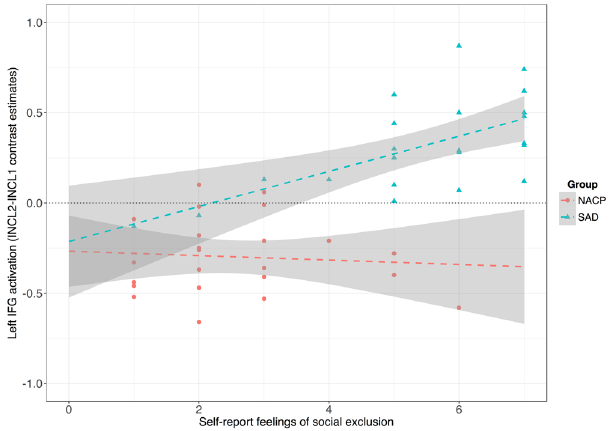
Figure 4. Pearson correlations between the self-report post-manipulation feelings of social exclusion scores and activations within the left inferior frontal gyrus (IFG) for the INCL2-INCL1 contrast among individuals qualifying for the diagnosis of social anxiety disorder (SAD) and matched nonanxious control participants (NACPs). The grey zones represent the 95% confidence interval of the linear